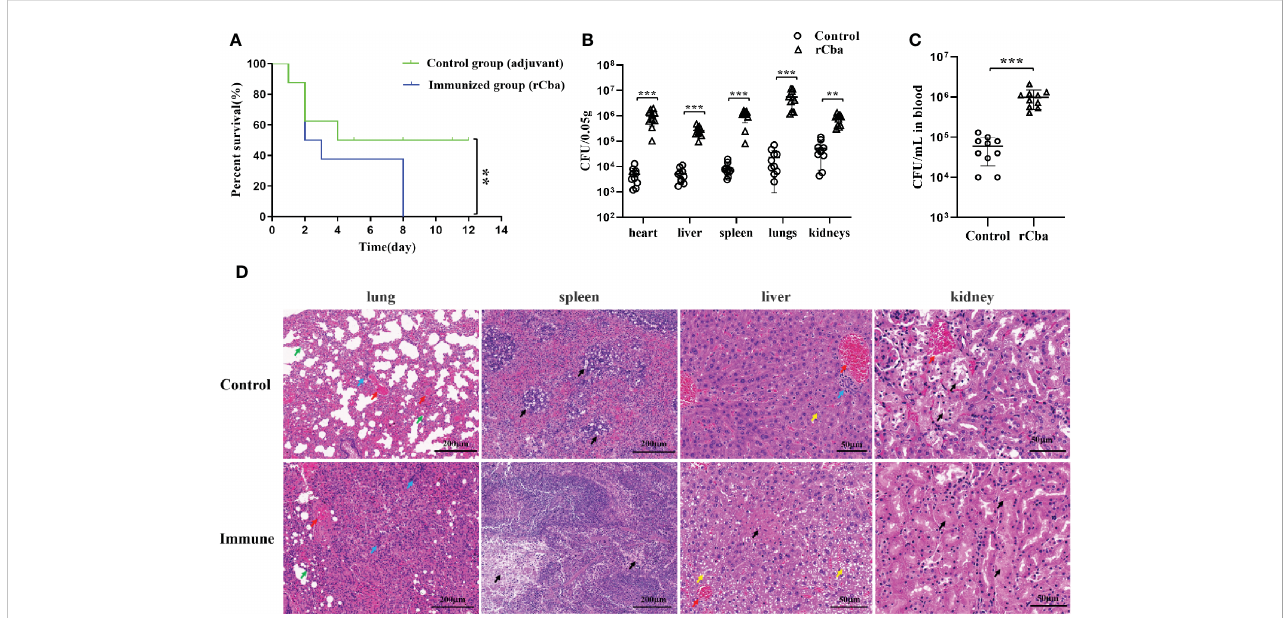
FIGURE 6 Intramuscular immunization with rCba aggravated the pathogenic effect of SS in Mice. (A) Kaplan-Meier survival curves of immunized mice with SS9-P10 infection. Were monitored daily for 2 weeks. The statistical signi fi cance was analyzed by log-rank (Mantel-Cox) test (n=8, **P <0.01 ); bacterial loads in (B) blood or (C) tissue homogenate of the heart, liver, kidney, lungs, and spleen at 24 h were determined via colony plate counting. (n=10, ** P <0.01, ***P<0.001 ); (D) Histopathological damage assessment of the lung, liver, spleen and kidney tissue of mice immunized with rCba and adjuvant after challenge with SS9-P10. Fatty degeneration in the liver is indicated by a yellow arrow, and hepatocytes show obvious microvesicular steatosis with a tendency to fuse similar to that in macrovesicular steatosis; hyperemia in the lung and liver is indicated by a red arrow, in fi ltration of in fl ammatory cells in the lung and liver is indicated by a blue arrow; thickening of the lung interstitium is indicated by a green arrow; and necrosis in the liver, spleen, and kidney is indicated by a black